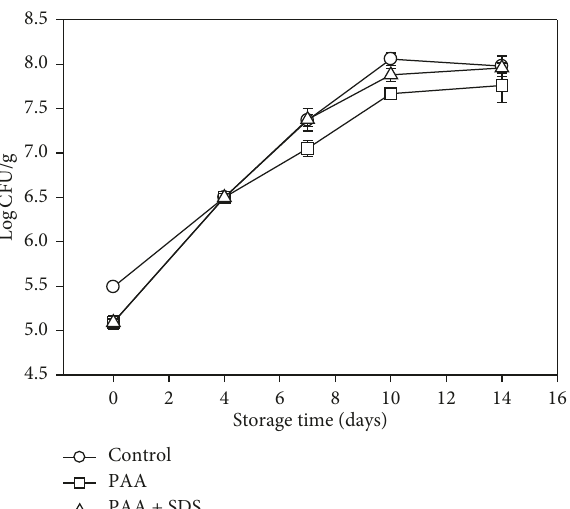
Figure 4: Counts of Pseudomonas spp. on baby spinach leaves treated with tap water (control), peroxyacetic acid (PAA), or peroxyacetic acid+ sodium dodecyl sulphate (PAA+SDS), during storage at 4 ° C for 14d. Error bars represent the standard error of the mean ( n � 3).